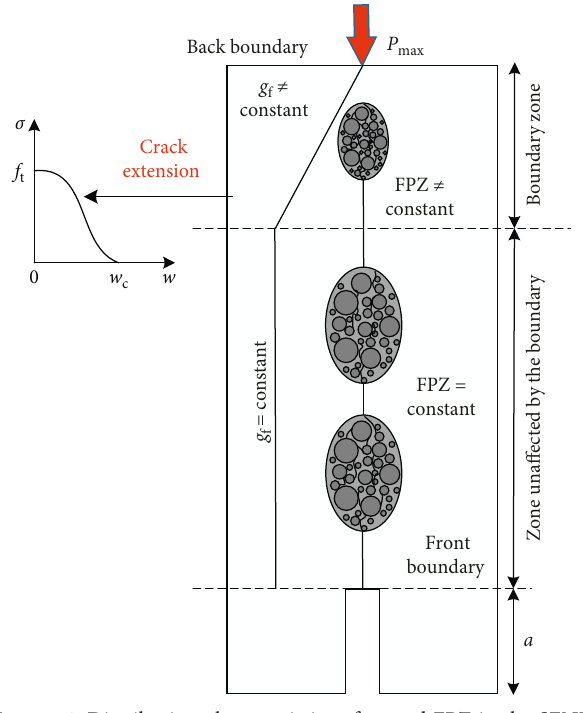
and FPZ in the SENB f